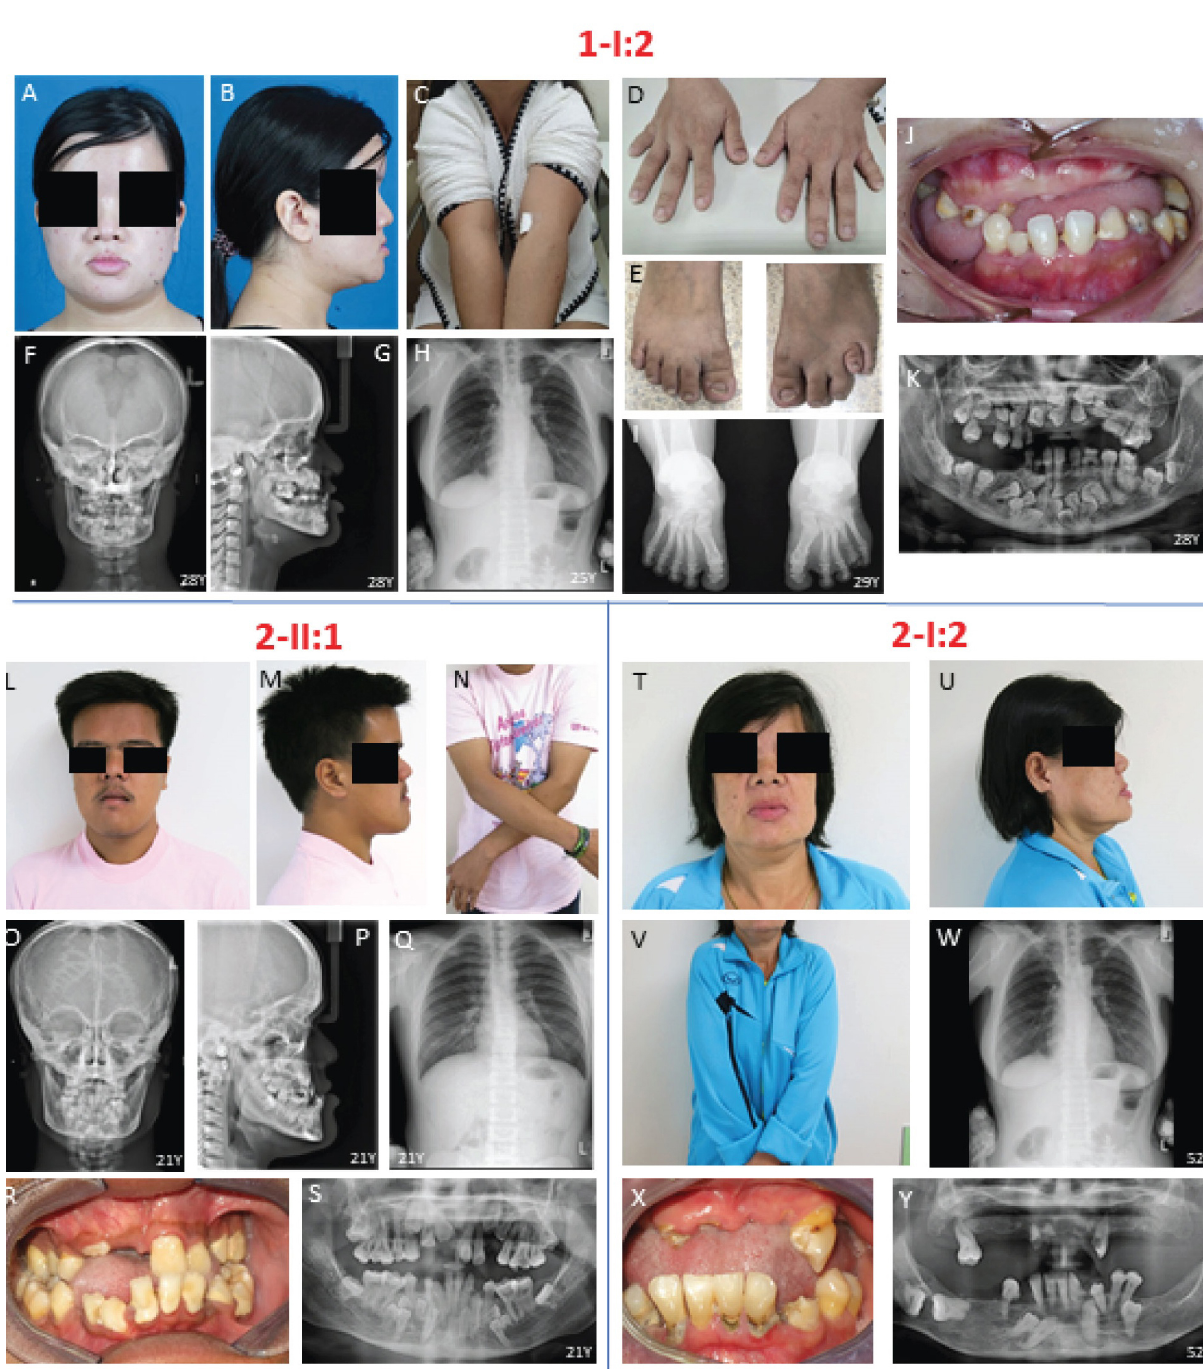
Figure 1- Clinical and radiographic features of 1-I:2, 2-II:1, and 2-I:2. (A-K) 1-I:2 shows typical CCD craniofacial features, narrow shoulder, and brachydactyly and short fourth toe of the left foot. Radiographs shows hypoplasia of the lateral part of both clavicles, widened cranial sutures, Wormian bones, fourth-ray brachymetatarsia of the left foot, unerupted teeth, and supernumerary teeth. (L-S) 2-II:1 shows normal clavicles, CCD facial features with asymmetry, widened cranial sutures, Wormian bones, spina bifida in the lower cervical spine, scoliosis of the lower thoracic spine, supernumerary teeth. (T-Y) 2-I:2 has unerupted teeth and normal